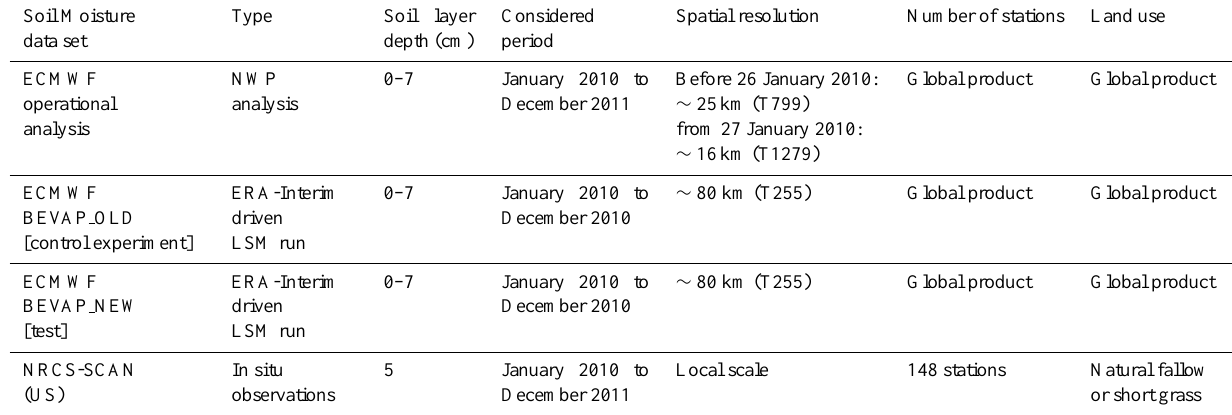
Table 1. The soil moisture products used in this study. NWP stands for numerical weather prediction and LSM for land-surface model. Soil Moisture data